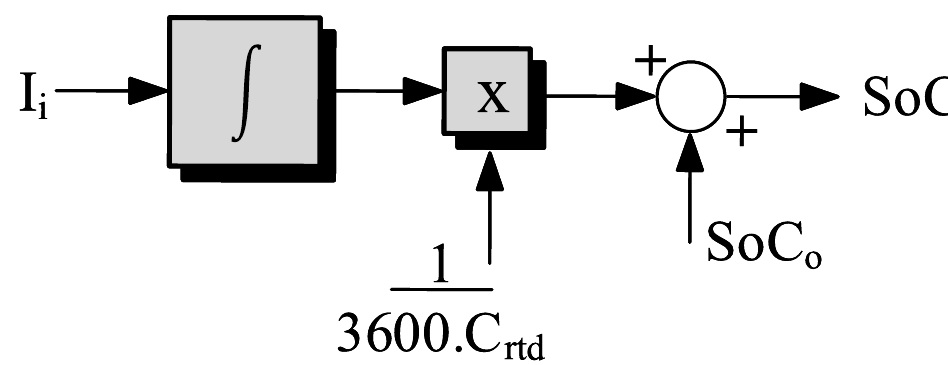
Figure 3. Block diagram for Coulomb counting estimation